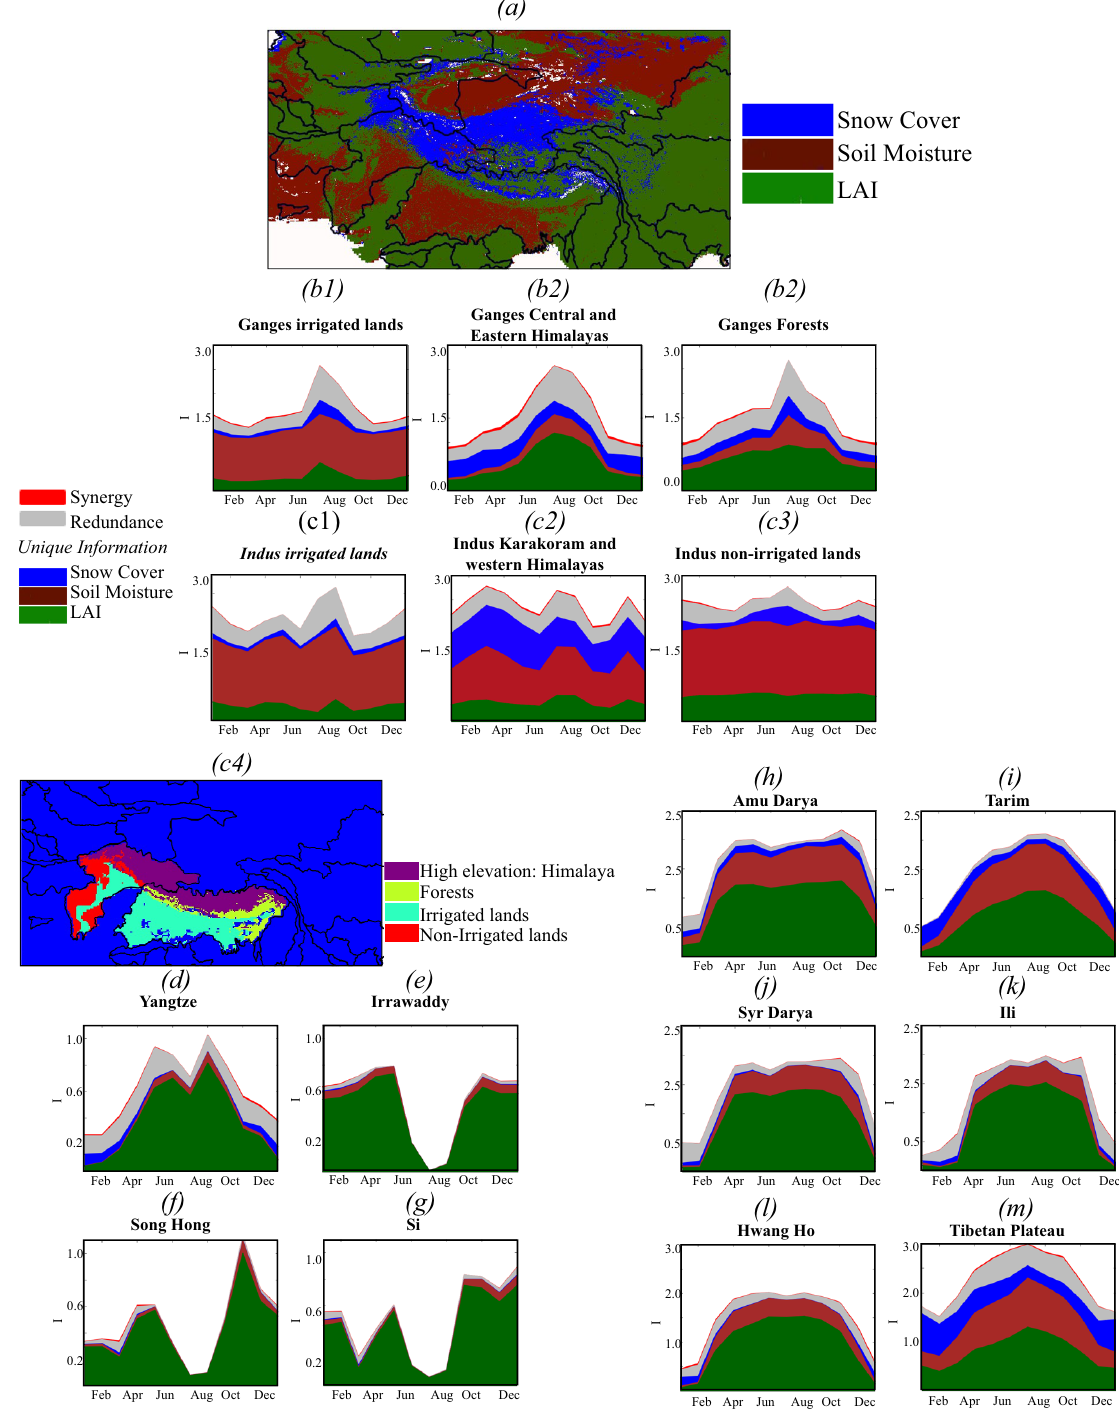
Figure 3. Dominant drivers of the surface albedo changes. ( a ) map of the dominant drivers of the surface albedo changes (i.e., the variable with the highest unique information). ( b – m ) Temporal variations of the unique, synergistic, and redundant information of leaf area index, soil moisture, and snow cover about the visible white-sky surface albedo of 16 zones (basin names are indicated in Fig. 1c and subregions c4). Note that y-axis is a stacked graph and is not